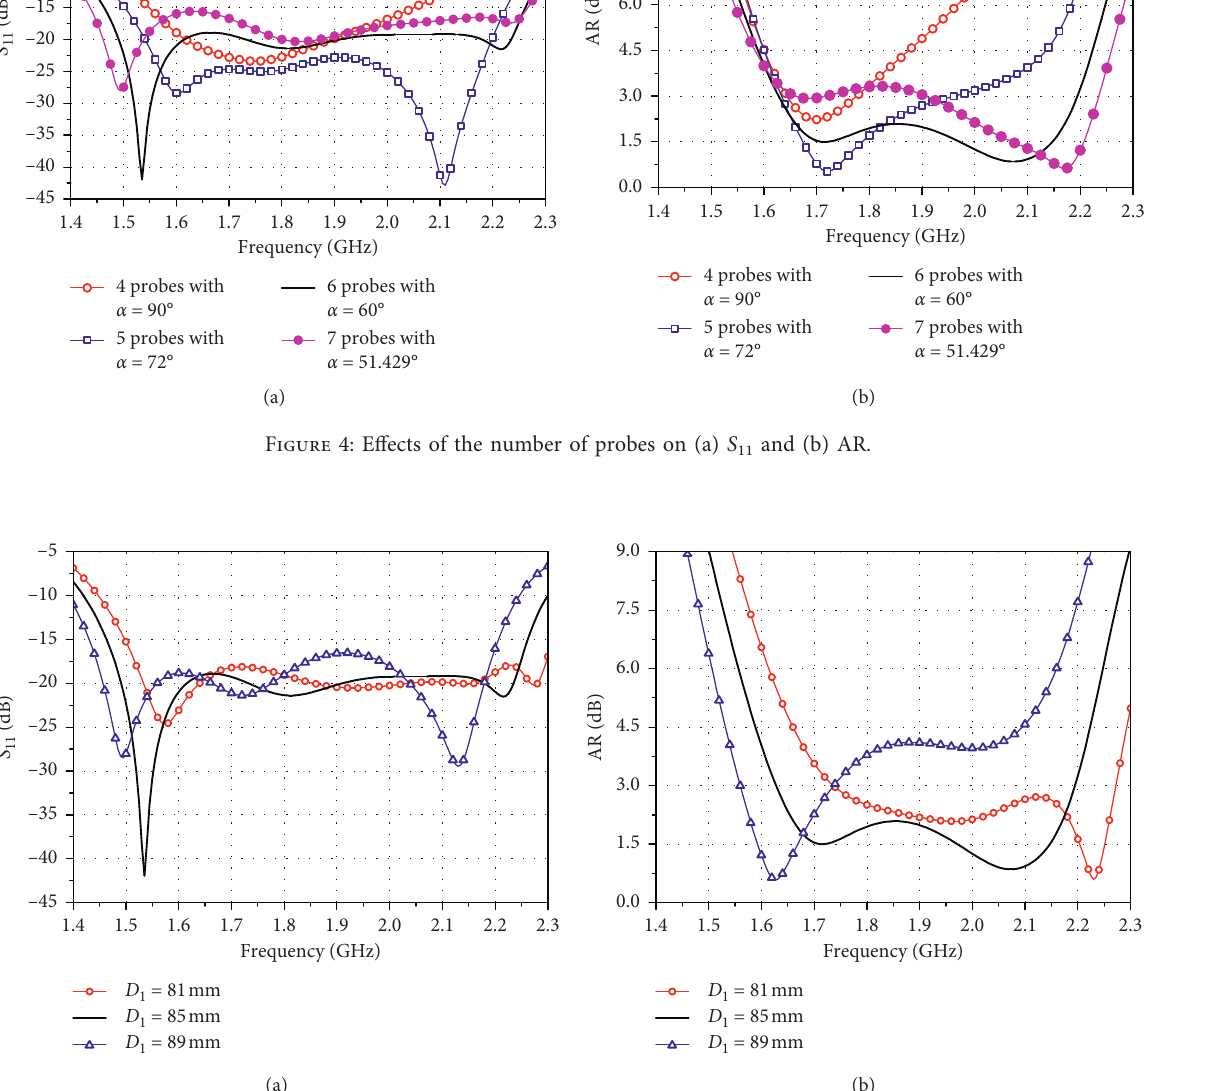
1 of patch 1 on (a) S 11 and (b) AR.